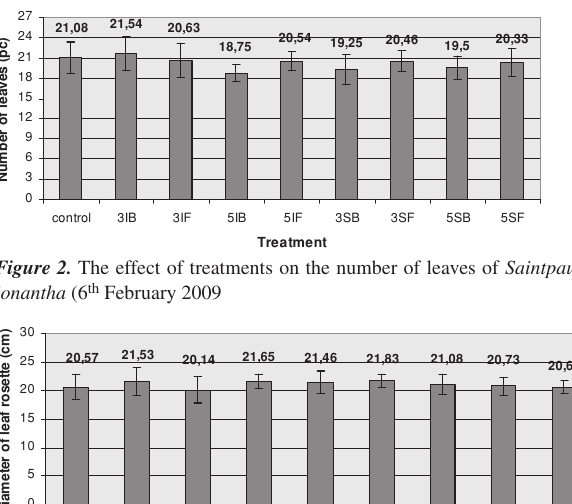
Figure 4. The effect of treatments on leaf size of Saintpaulia ionantha (6 th February 2009)